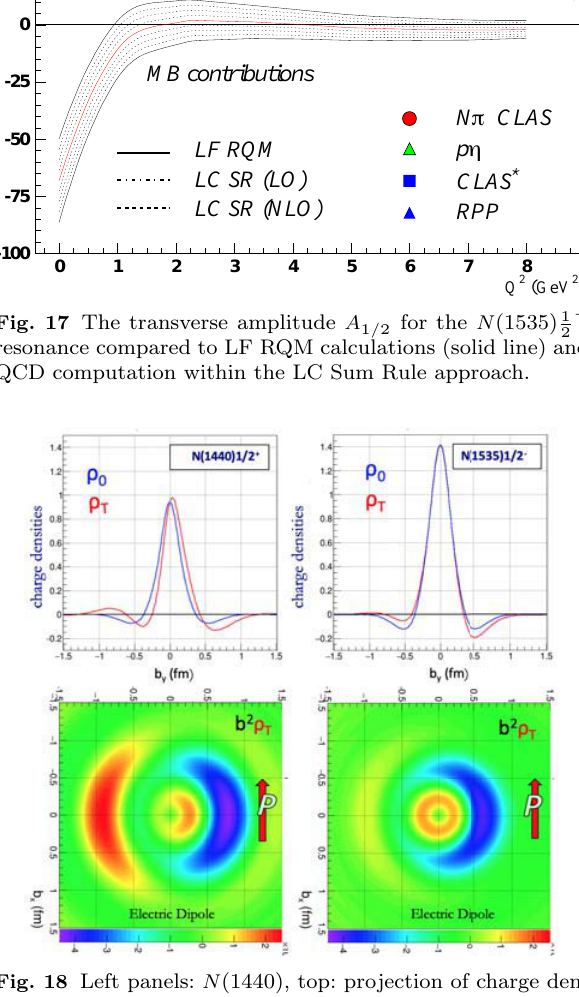
Fig. 18 Left panels: N (1440), top: projection of charge den- sities on b y , bottom: transition charge densities when the proton is spin polarized along b x . Right panels: same for N (1535). Note that the densities are scaled with b 2 to em- phasize the outer wings. Color code:negative charge is blue, positive charge is red. Note that all scales are the same.